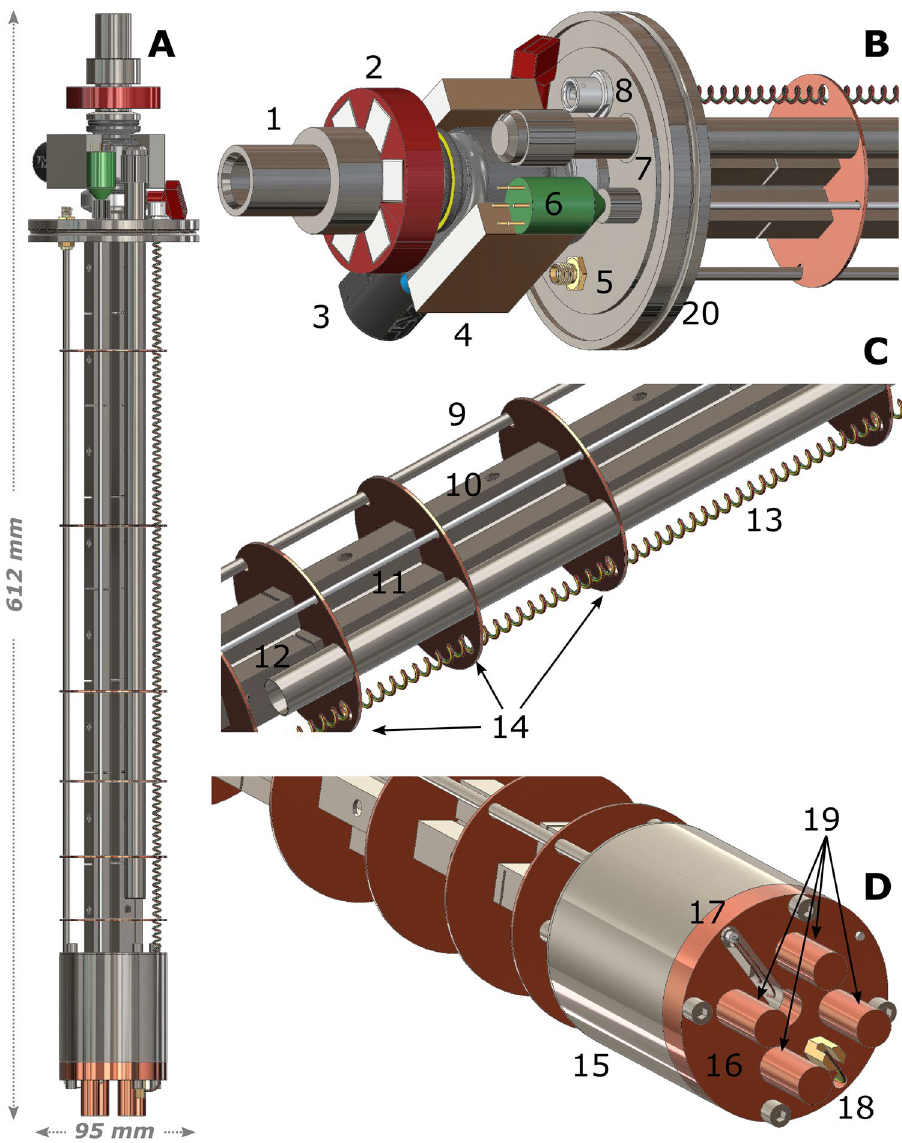
Figure 2. 3D drawings of the probe built to transfer HP samples from the dDNP polarizer to the compact bath cryostat and store them inside a magnetic field and at a temperature of 4.2 K. We report its front view ( A ), as well as magnified pictures of the top part ( B ), middle part ( C ) and bottom part ( D ). The most important elements are indicated with numbers: loading chamber (1); six elements Halbach magnetic array around loading chamber (2); gate valve (3); two elements Halbach magnetic array around gate valve (4); NMR circuit SMA connector (5); liquid He probe pin connector (6); liquid He syphon port (7); Fischer connector for thermometer (8); NMR circuit coax cable (9); squared profile for four elements Halbach magnet array (10); liquid He probe stem (11); liquid He syphon (12); quartet of twisted cryogenic wires (13); copper horizontal radiation shields/ baffles (14); sixteen elements storage Halbach magnetic array (15); copper bottom (16); coax cable termination with connection to the solenoidal coil (17); cernox temperature sensor (18); probe’s copper tails